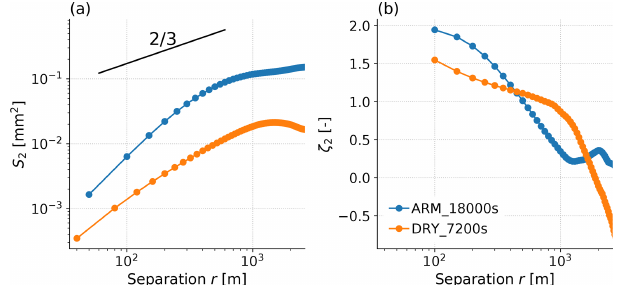
Figure 3. (a) S 2 calculated from TCWV for two LES snapshots as a function of separation distance, with the 2 / 3 gradient associated with a passive tracer in turbulence following Kolmogorov theory also shown; (b) exponent calculated locally at each separation dis-